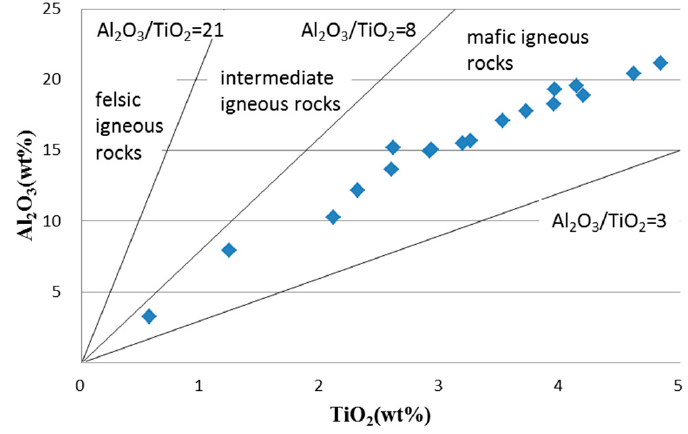
Figure 15. Bivariate plot for Al 2 O 3 and TiO 2 in No 1 coal seam of the Shugentian coalfield.